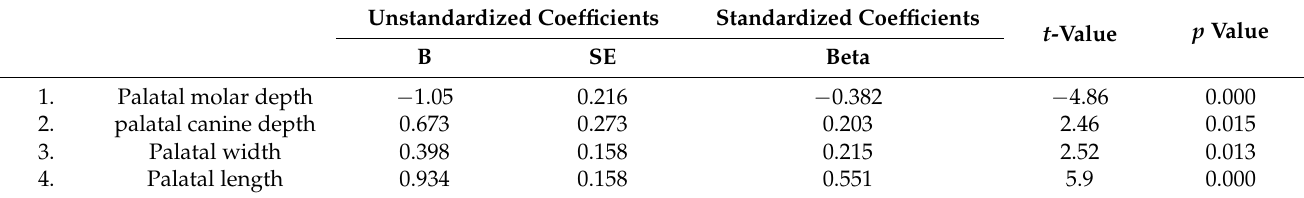
Table 5. Multiple regression analysis of arch perimeter (as a dependent variable) and several co-variates ( n = 4).